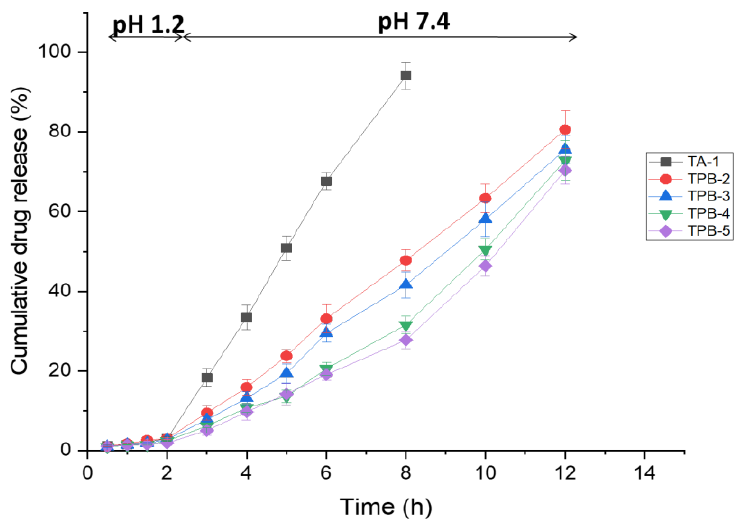
Figure 7. Cumulative drug release % of TRHC-PAG-alginate microspheres from 1–2 h in pH 1.2 and 3–12 h in pH 7.4 (Mean ± SD, n = 3).